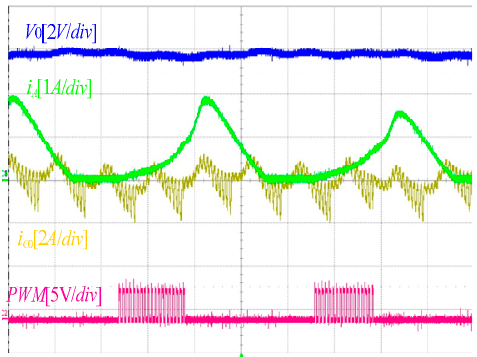
Figure 14. The experiment waveforms of output voltage under CC-PT control.